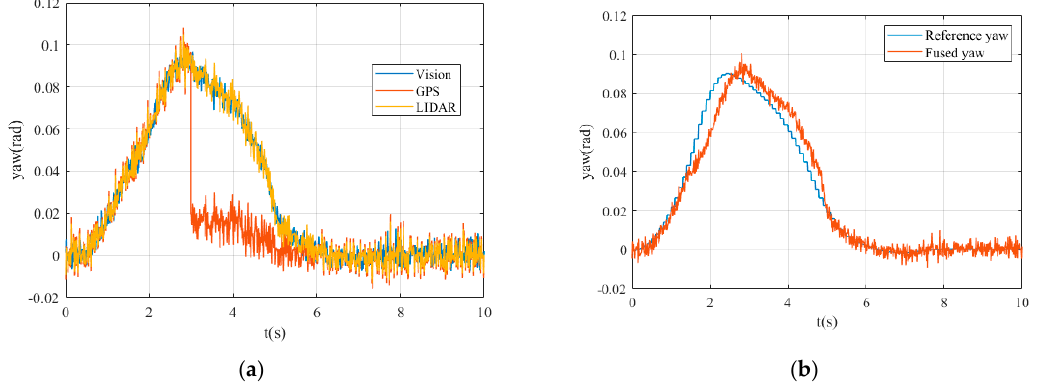
Figure 5. Driving scenario and reference path: ( a ) driving scenario; ( b ) reference path.